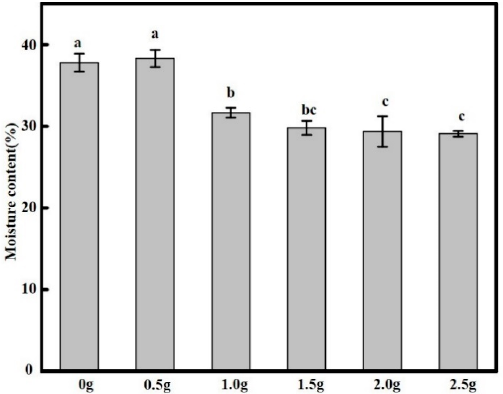
Figure 3. Moisture content of SA/CMC films added with different concentrations (g/100 g) of Lactococcus lactis . Data followed by different lowercase letters are significantly different ( p < 0.05) when comparing moisture content.